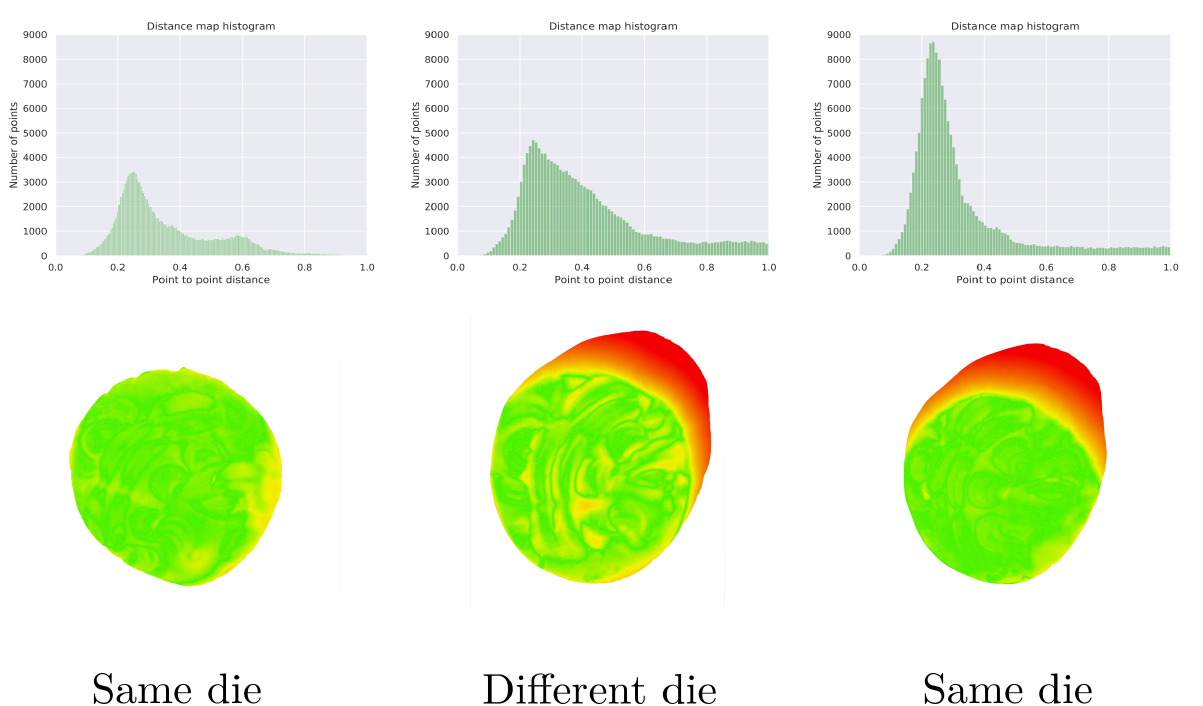
Figure 4. 3 examples of distance map between two pair of coins on the bottom and their respective histogram on the top.